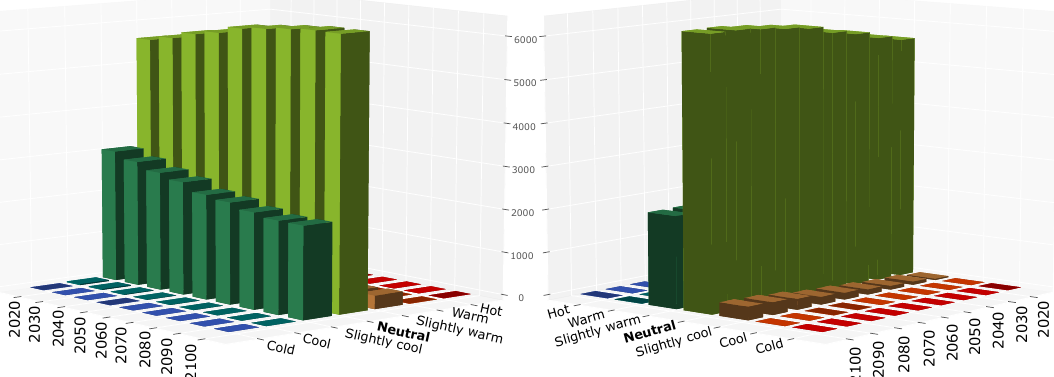
Figure A1. Comfort results taking into account the NBE CTE-79 standard and the Pamplona weather file generated with Meteonorm based on the IPCC scenario